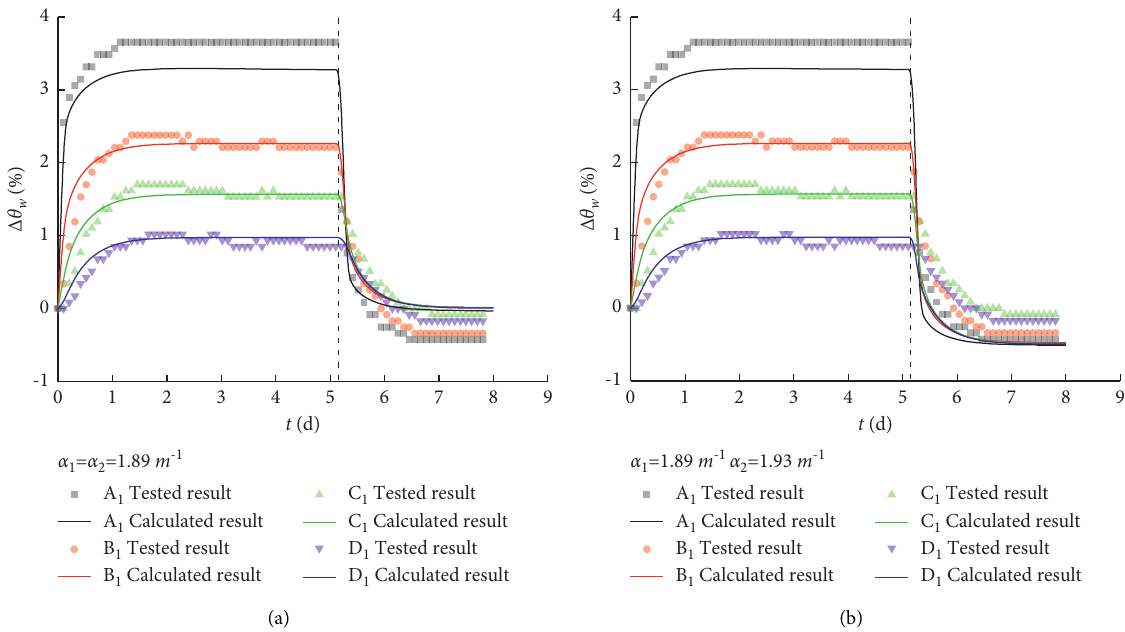
Figure 4: Comparison of the volumetric water content with numerical calculation in case 1: (a) α α 2 � 1.93m − 1 .